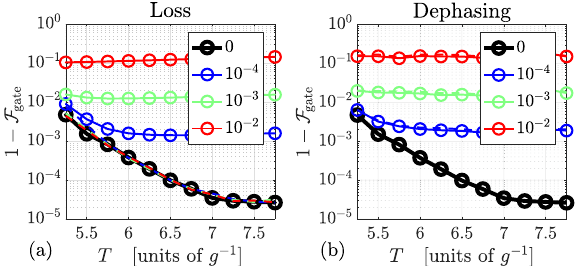
Fig. 7 Example of Fourier domain control function. This particular Fig. 6 Dependence of the gate error on decoherence. a 1 (cid:5) F gate example leads to a gate error of 1 (cid:5) F gate ¼ 4 : 7 ´ 10 (cid:5) 5 . Parameters: as a function of gate duration, T , for different cavity loss rates (legend corresponds to κ l / g ). b 1 (cid:5) F gate as a function of gate = 0.14. duration, T , for different dephasing rates (legend corresponds to γ dp / ch / g g ). In both ( a ) and ( b ), the dashed lines plot the error in conditional Ω : 4 Ω Ω = 15 g , and fi delity. Simulation parameters: κ C ¼ 6 G , g ¼ 0 G , 0 T in = 4.3/ g . In ( a ) we used γ dp = 0 and γ e = κ l ≠ 0 and in ( b ) we used = κ = 0 and γ ≠ 0. γ e l dp